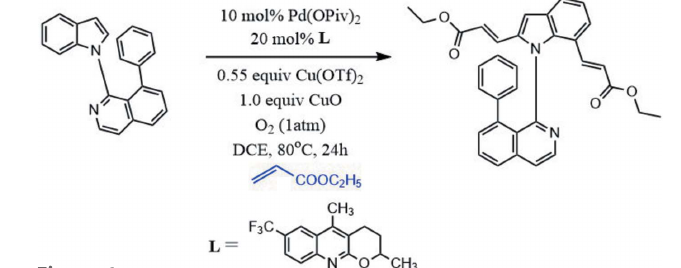
Figure 6 Synthesis of the title compound.